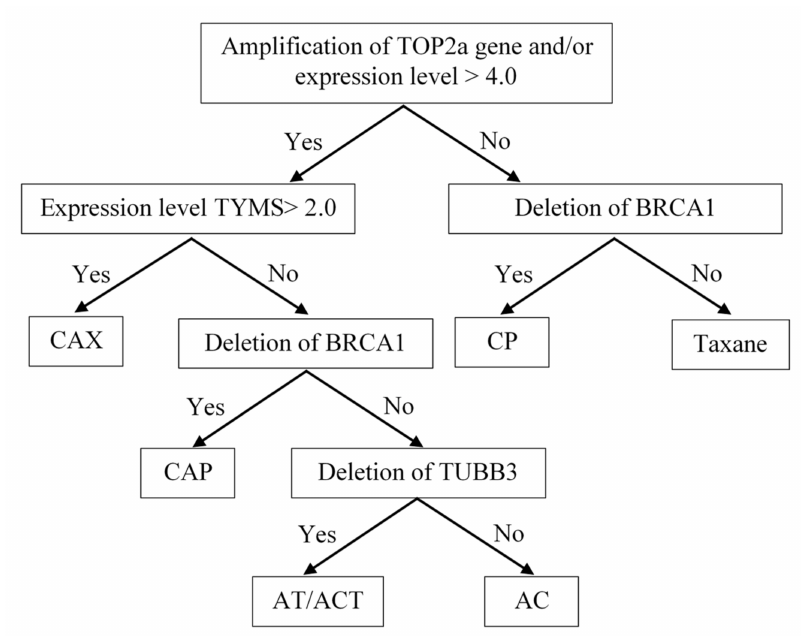
Figure 4. Algorithm for personalized prescription of NAC to patients with breast cancer. NAC regimen: CAX—cyclophosphamide, doxorubicin, Xeloda; CP—cyclophosphamide, cisplatin; CAP— cyclophosphamide, doxorubicin, cisplatin; AT—doxorubicin, docetaxel; ACT—doxorubicin, cy- clophosphamide, docetaxel AC—doxorubicin, cyclophosphamide; Taxane—Taxotere in